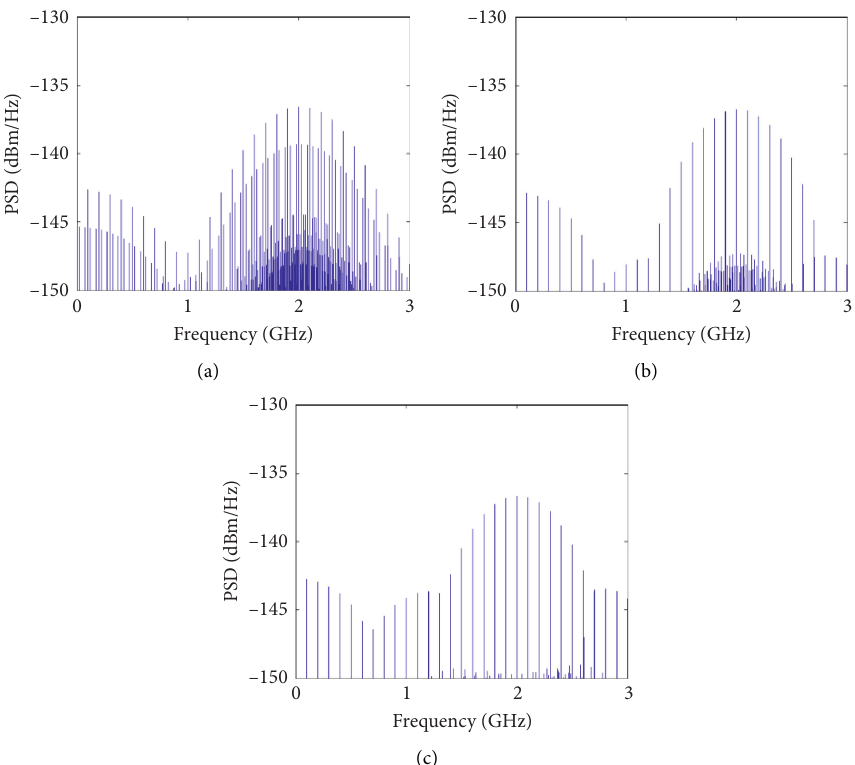
Figure 3: The PSD of TH-PPM UWB (PRF � 20MHz). (a) PRF � 20MHz, Np � 10. (b) PRF � 20MHz, Np � 50. (c) PRF � 20MHz, Np �